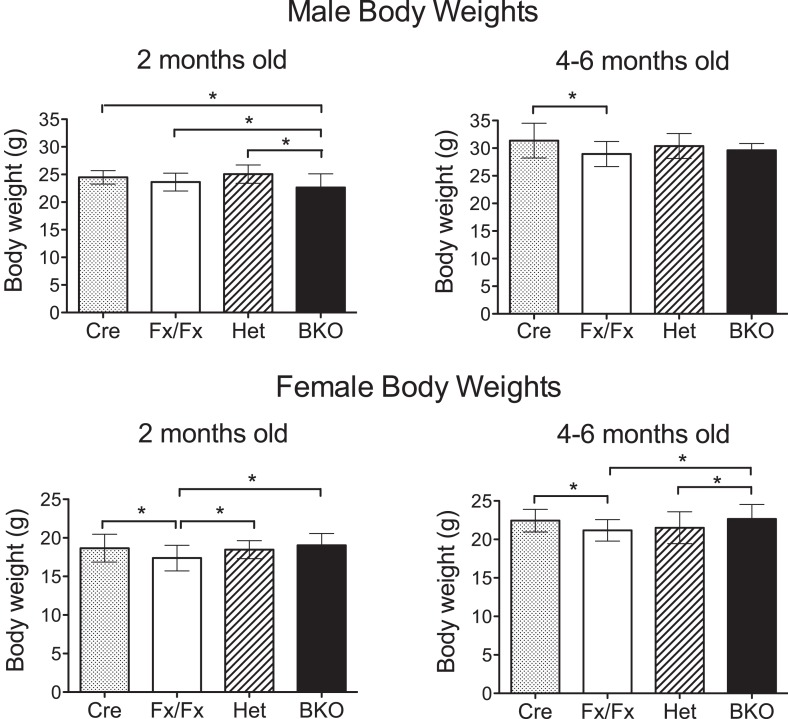
Weights of Bmal1 brain knockout mice are similar to controls at 2 months and 4–6 months of age.All body weights were measured in live, wheel-naïve animals. Numbers of male mice weighed at 2 months (= 54- to 62-day old) and 4–6 months (= 120- to 195-day old), respectively: Cre (n = 25, 35), Het (n = 13, 15), Fx/Fx (n = 98, 37), and BKO (n = 55, 12). Numbers of female mice weighed at 2 months and 4–6 months, respectively: Cre (n = 28, 39), Het (n = 23, 35), Fx/Fx (n = 84, 54), and BKO (n = 54, 29). Shown are the mean weight ±SD. A significant effect of genotype was found using GLM ANOVA, followed by Tukey–Kramer multiple comparison post-tests. The difference between Cre and Fx/Fx mice (*p ≤ 0.05) is likely due to the difference in the genetic background (CamiCre+ is generated in FVB background and floxed Bmal1 in 129sv). Importantly, there was no significant difference between BKO males and control males at 4–6 months, and BKO females did not weigh less than any control group at either time point.